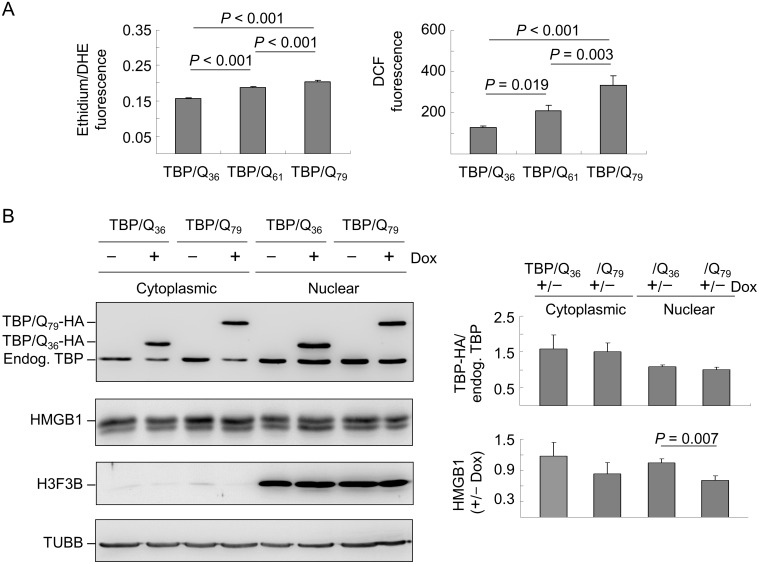
ROS and HMGB1 distribution in TBP/Q36∼79 293 cells.(A) 293-derived cells were induced for 6 days to express TBP/Q36∼79. The cells were loaded with DHE and DCFH-DA, and superoxide/peroxide production was fluorometrically quantified. The data are expressed as the mean ± SD of three independent experiments. (B) Cells were induced for 6 days to express TBP/Q36 and TBP/Q79. The extracts were fractionated into cytoplasmic and nuclear components and analyzed using TBP, HMGB1, H3F3B (histone H3.3) and TUBB antibodies. The induced TBP/Q36∼79-HA protein level relative to endogenous TBP and the level of HMGB1 (+/–Dox) were normalized to the loading control, β-tubulin (TUBB). Values are expressed as the means ± SD of three independent experiments.